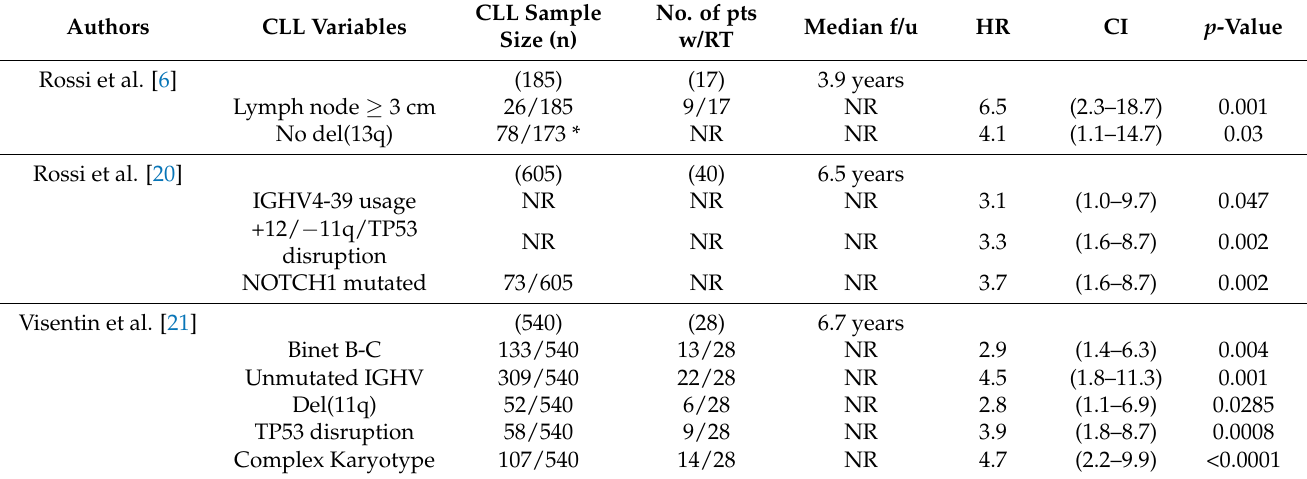
Table 1. Risk factors associated with Richter Transformation in untreated CLL